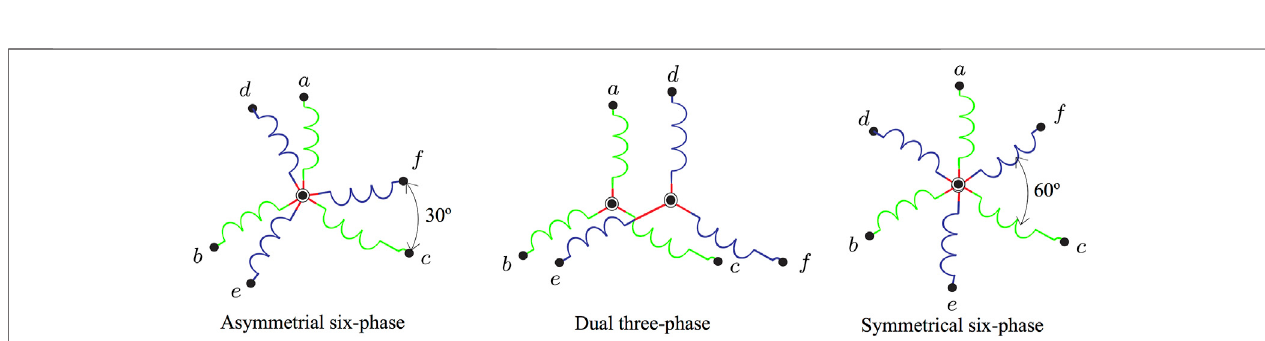
FIGURE 4 | Six-phase IM winding arrangements.